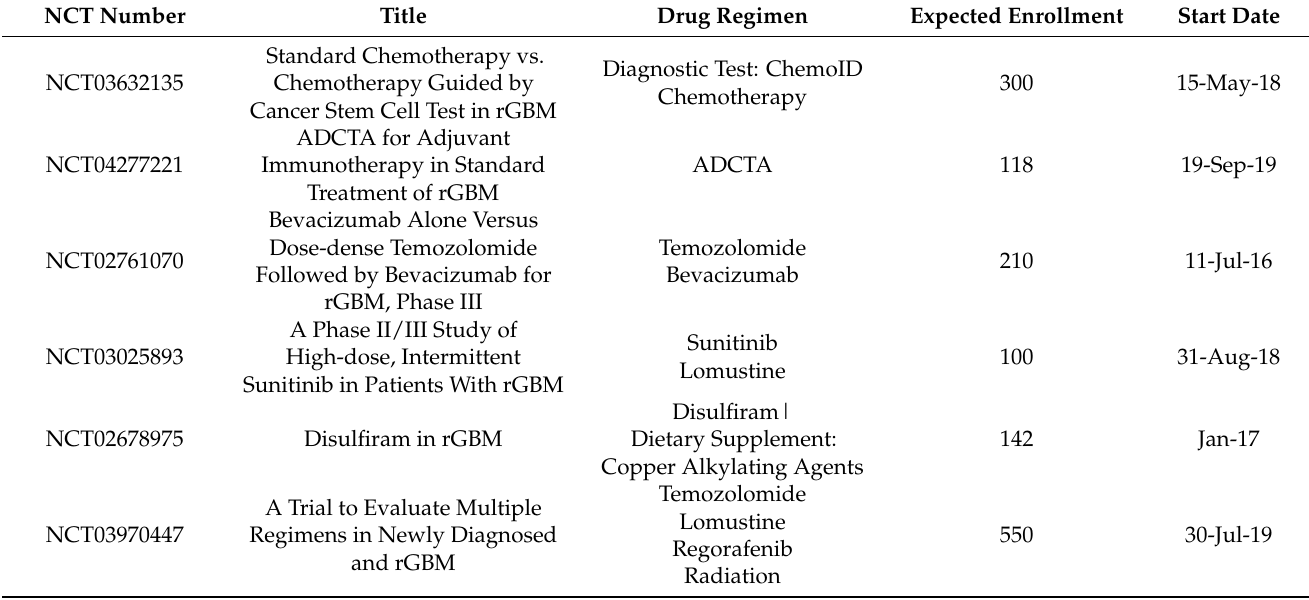
Table 1. Ongoing major phase III clinical trials in GBM.